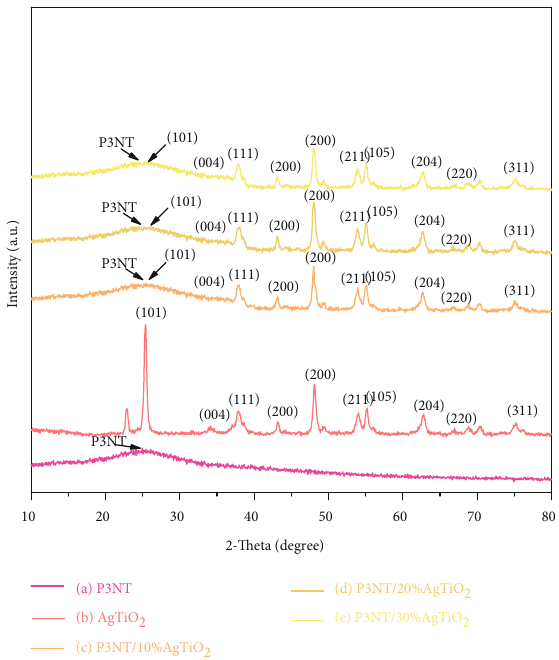
Figure 2: XRD pattern of the P3NT (a), AgTiO P3NT/10%AgTiO and binary